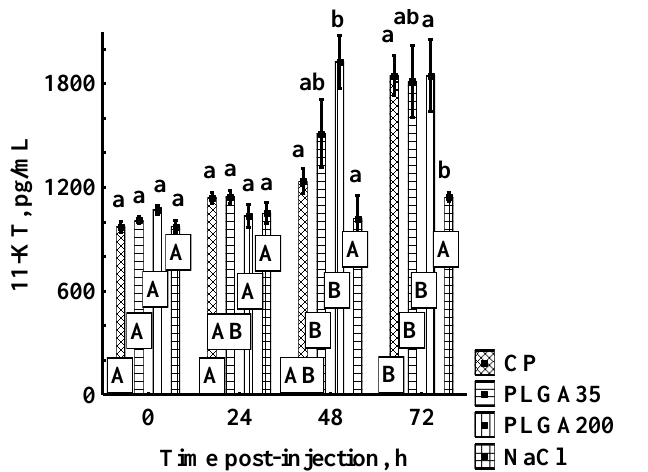
Figure 3. 11-KT concentration with and without hormone treatment in sterlet. Significant differences among groups at a sampling point are indicated by lower case letters ( p < 0.05). Significant differences within an experimental group are indicated by upper case letters ( p < 0.05). Experimental